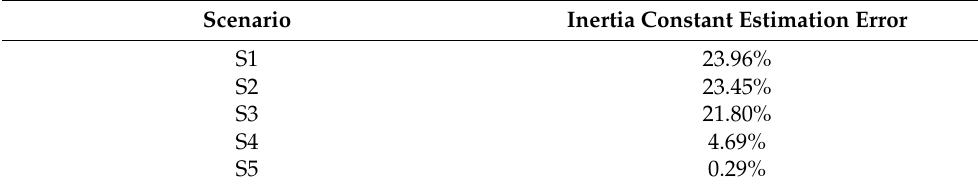
Table 4. System inertia constant estimation errors for different estimation